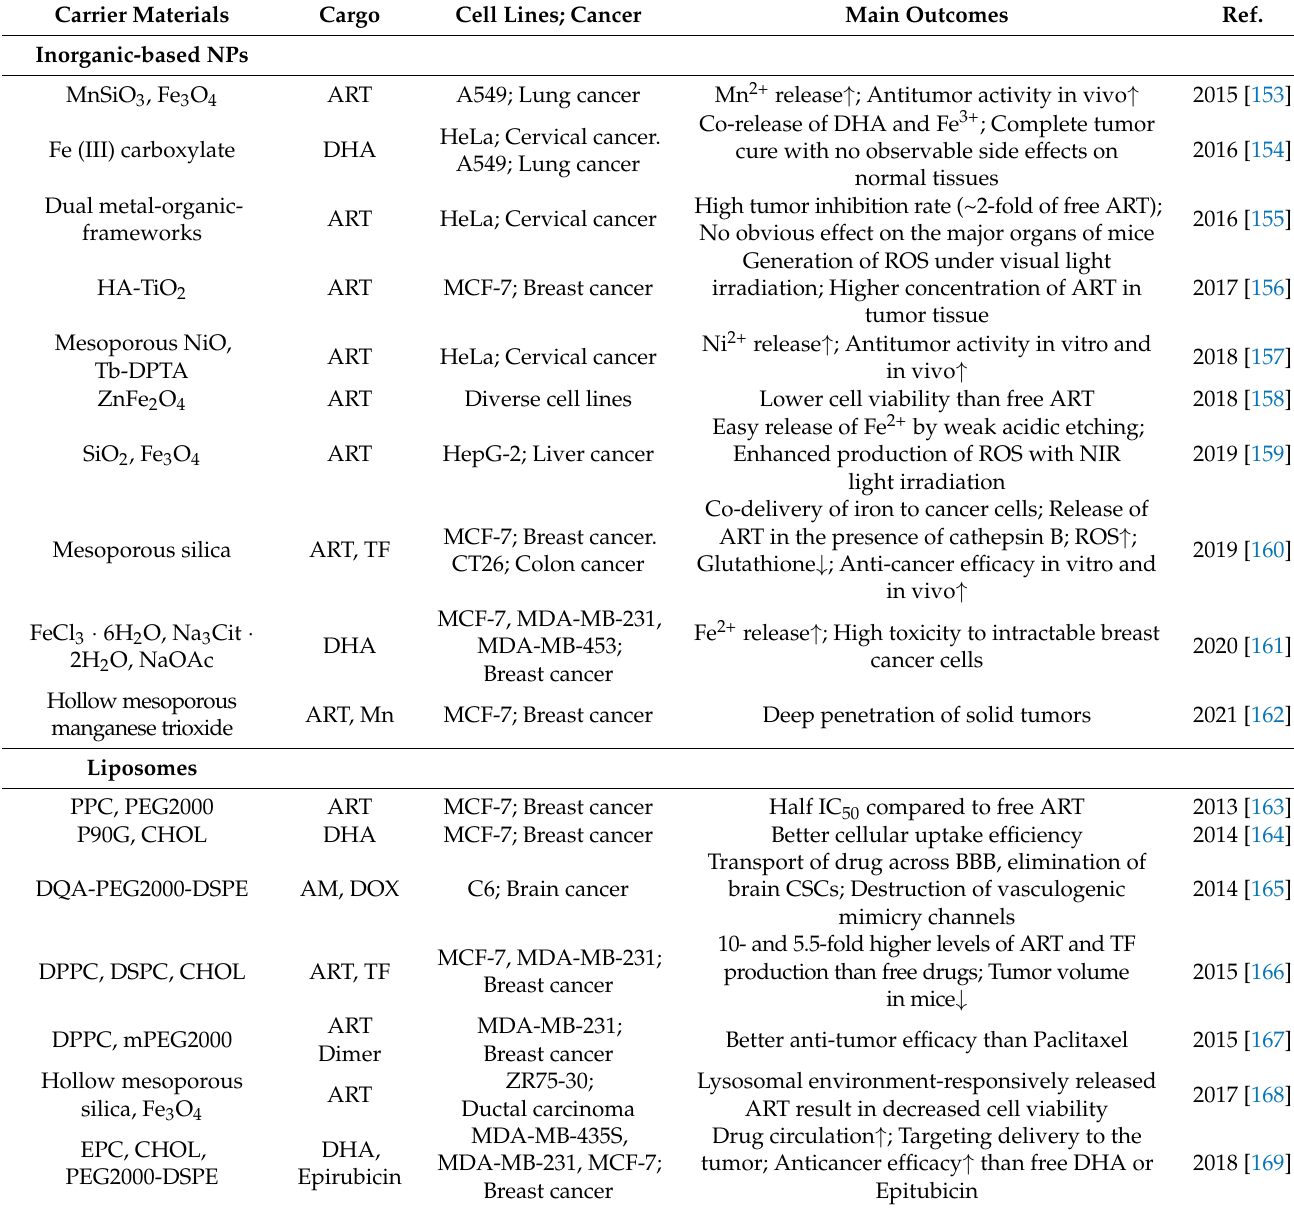
Table 5. List of studies reporting the delivery of ART-type drugs with nanocarriers detailing the carrier material, cargo, model systems and main findings of the studies compared to free drugs. Main Outcomes